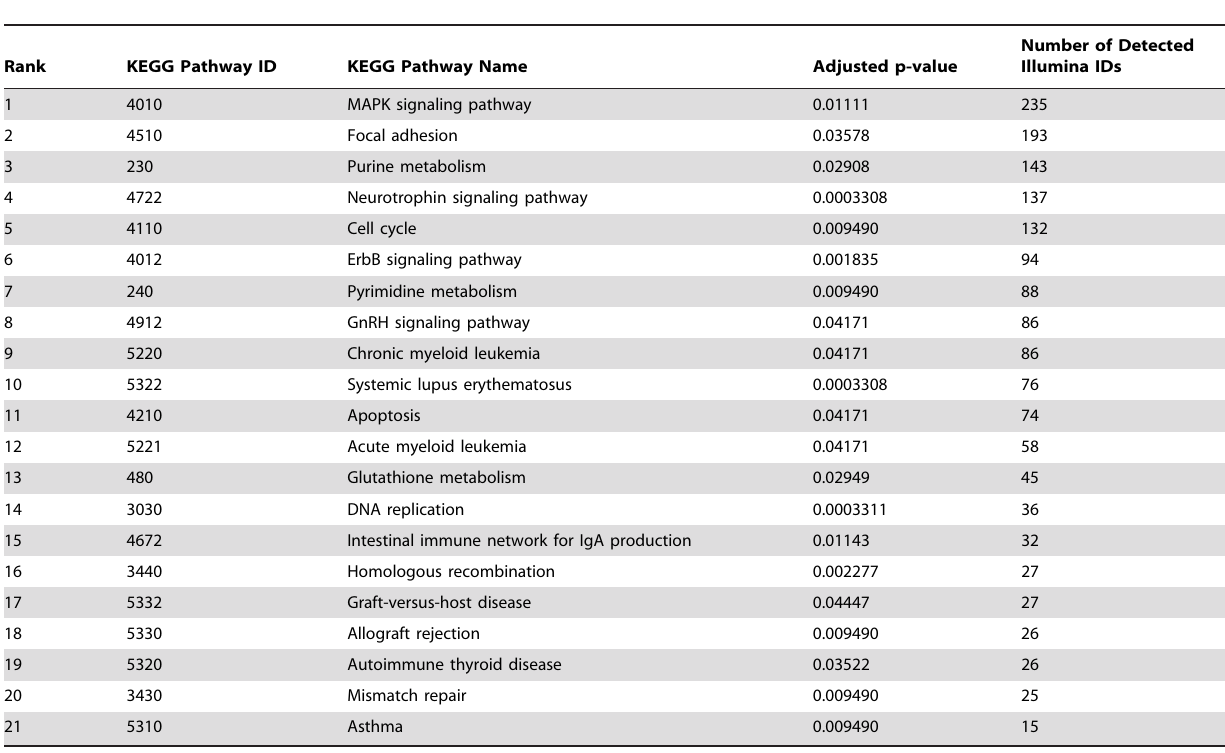
Table 1. The top 21 most discriminating KEGG pathways between the neuronal stem cells obtained from the disease and healthy control donor groups.